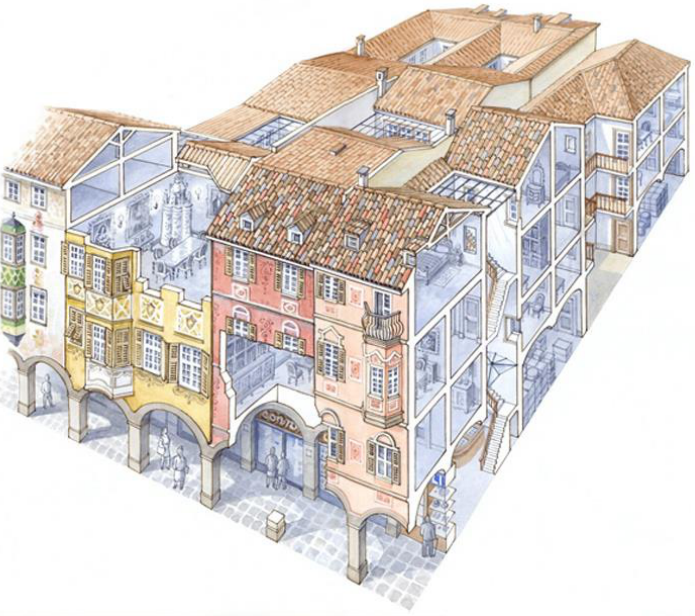
Figure 2. A scheme of a typical Portici house (© Antonio Monteverdi, http://www.antoniomonteverdi.com/sito/?page_id=1228, accessed on 10 July 2022).